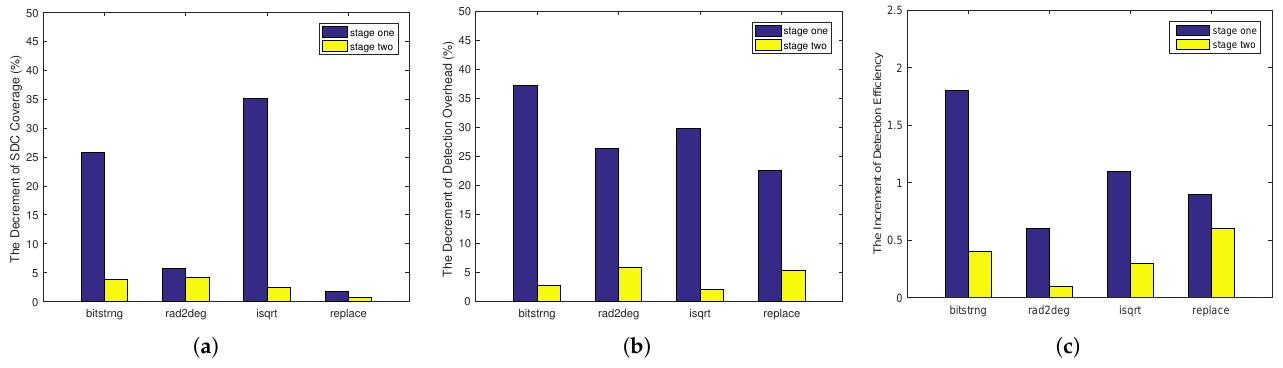
Figure 9. The decrement or increment of ( a ) SDC coverage, ( b ) detection overhead, ( c ) detection efficiency. The influences of the two stages on the benign detection ratio and detection degree were then evaluated, as shown in Figures 10 and 11. As exhibited in Figure 10, the averaged decrements of the benign detection ratio for stage one and stage two were 8.1% and 0.5%, respectively. As presented in Figure 11, the averaged increments of the detection degree for stage one and stage two were 0.04 and − 0.0008, respectively. In summary, the first stage made contributions to decreasing the benign detection ratio and improving the detection degree, while the second stage made little contributions. The reason for this is that, in comparison with stage one, the second stage did not consider the benign detection ratio or detection degree during assertion screening.